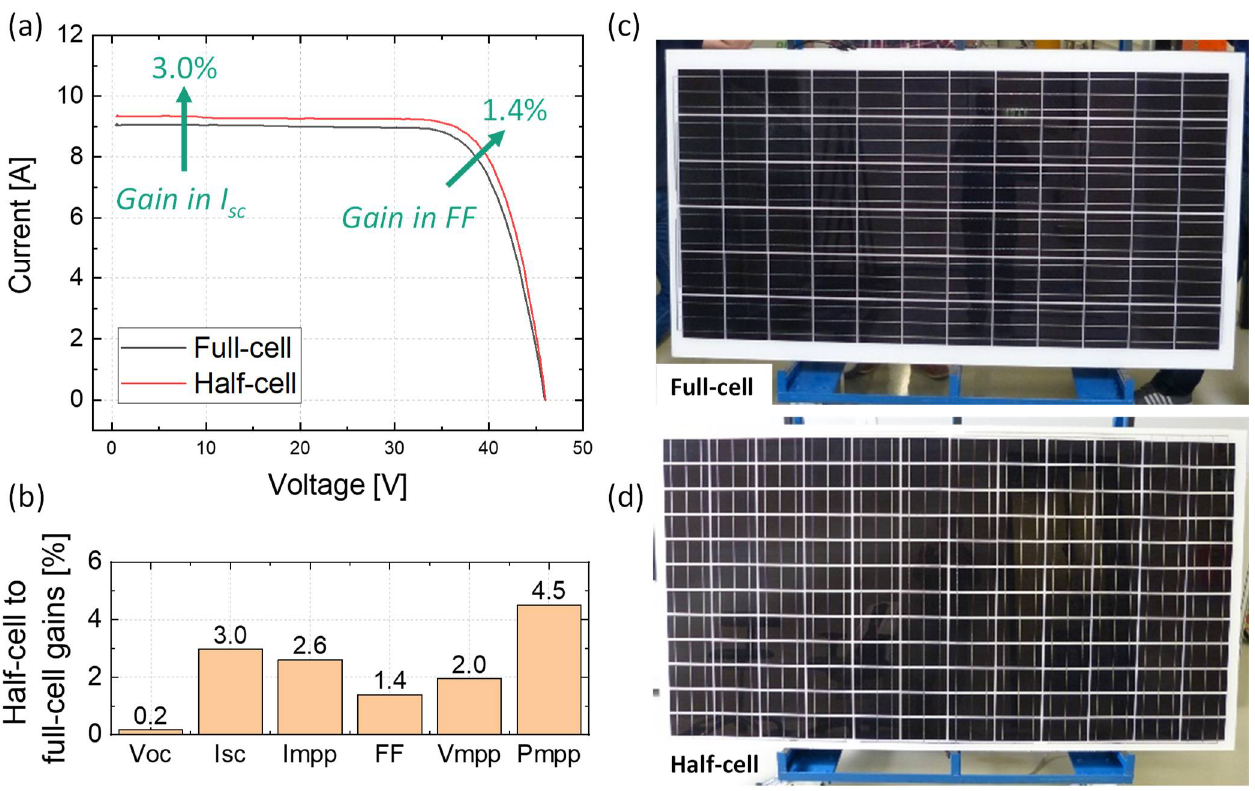
Figure 3. Comparison of ( a ) the IV characteristics and ( b ) electrical characteristics of measured ( c ) full-cell (72 cells) and ( d ) half-cell modules (144 half cells) with a similar bill of materials.